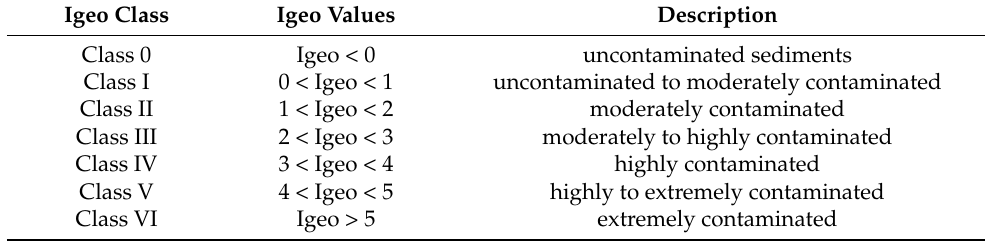
Table 4. Geo-accumulation Index categories [45,46].